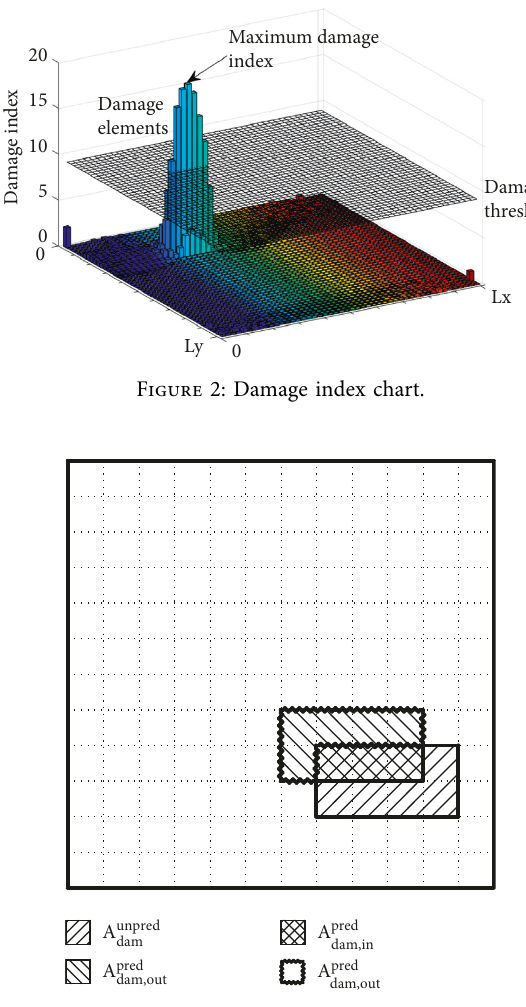
Figure 3: Illustration of the parameters to determine the detection capacity indicators.